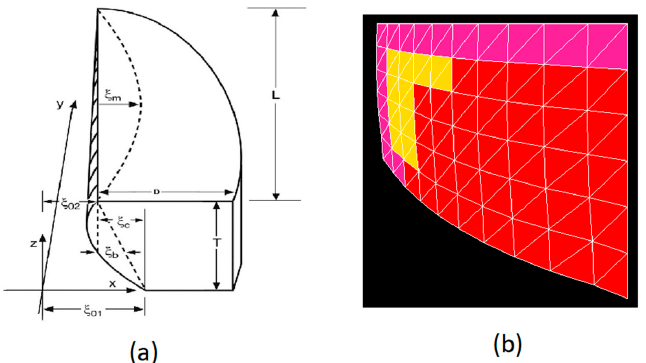
Figure 2. ( a ) Right vocal fold geometry in the Fiber-Gel Model, and ( b ) coronal section of the right vocal fold in finite element implementation. Purple is the superficial layer of the lamina propria (SLLP), yellow is the ligament, and red is the thyroarytenoid (TA) muscle.